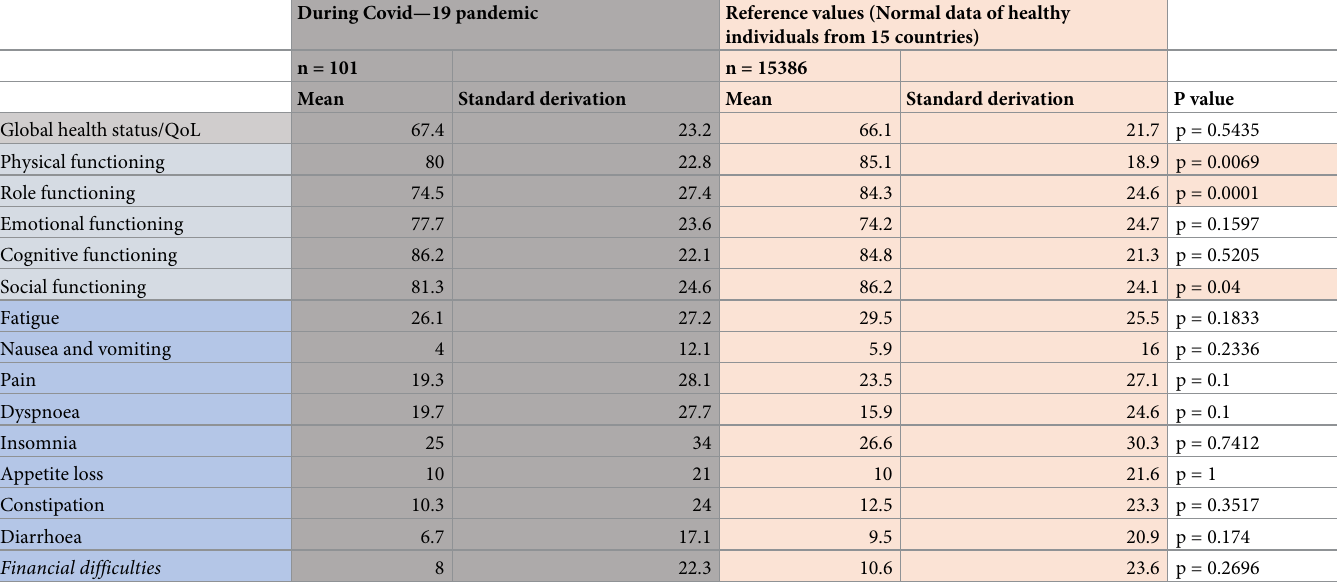
Table 5. EORTC quality of life questionnaire—C30 in comparison to healthy normal individuals. During Covid—19 pandemic Reference values (Normal data of healthy individuals from 15 countries)